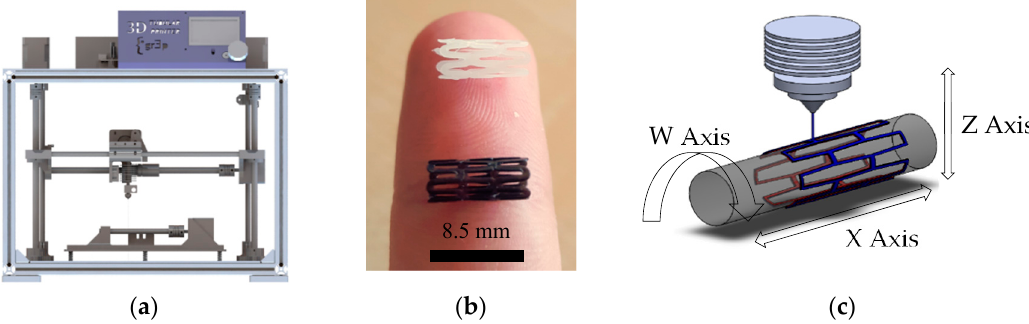
Figure 1. ( a ) 3D Tubular printer ( b ) 3D-printed stents [PCL in white, PLA in black] ( c ) Machine methodology. PCL: Polycaprolactone; PLA: Polylactide Acid.